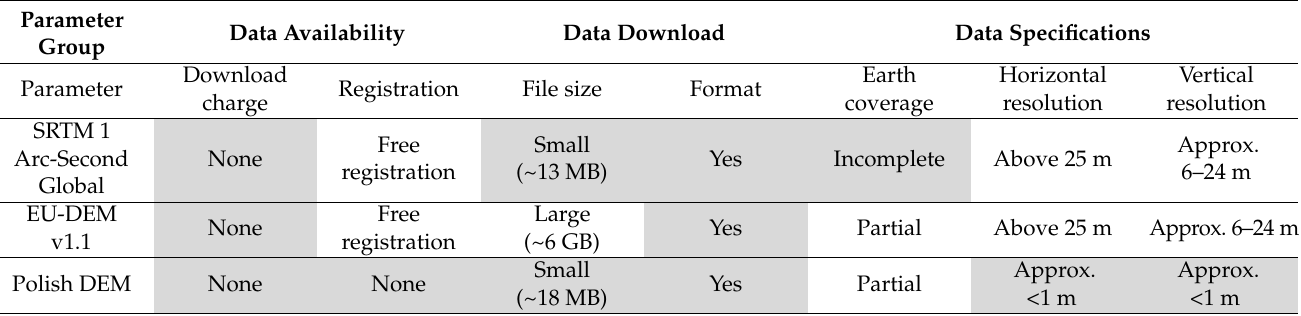
Table 5. DEM source parameters for global sea level rise analyses, for selected DEMs. Source: own elaboration.